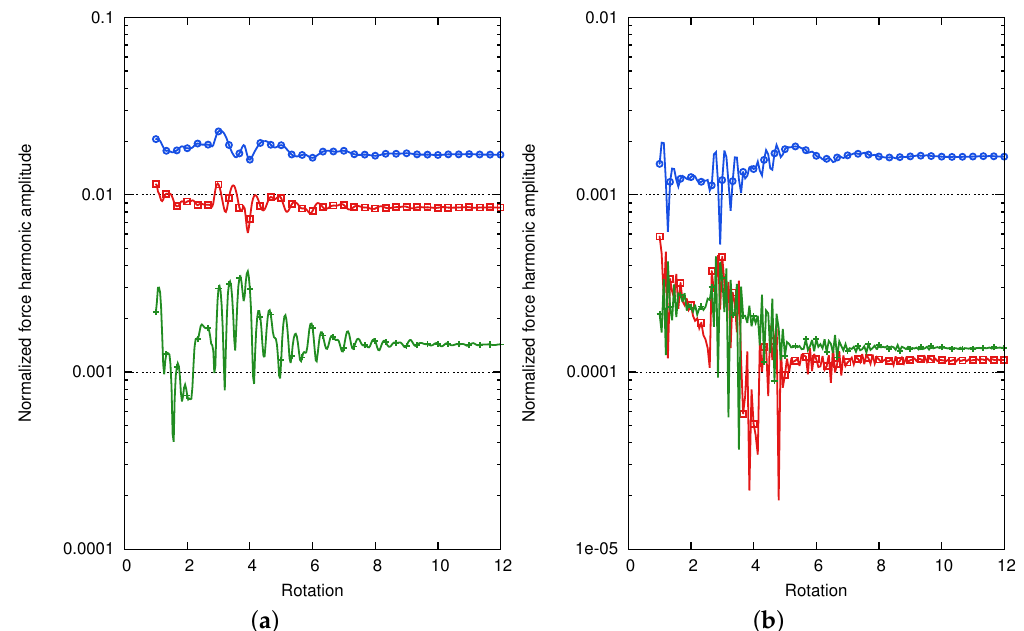
Figure 5. Evolution of the amplitude of one fan-blade force at the rotational frequency (RF) and its harmonics ( a ) and of one OGV force at the blade passing frequency (BPF) and its harmonics ( b ) normalized by the converged values of the corresponding mean forces: fundamental in blue line marked with circles, first harmonic in red line marked with squares and second harmonic in green line marked with crosses.